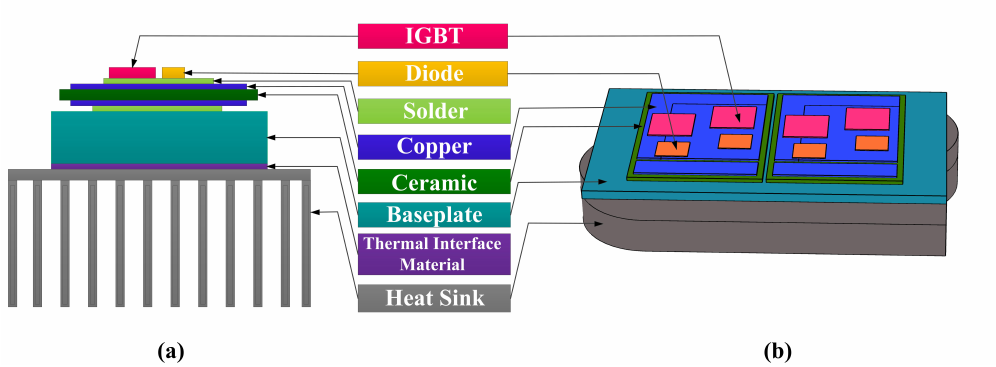
Figure 3. ( a ) An IGBT module with a heatsink and its different layers, ( b ) Schematic of the IGBT module modeled in Comsol Multiphysics. Table 1. Material thermal properties of the IGBT